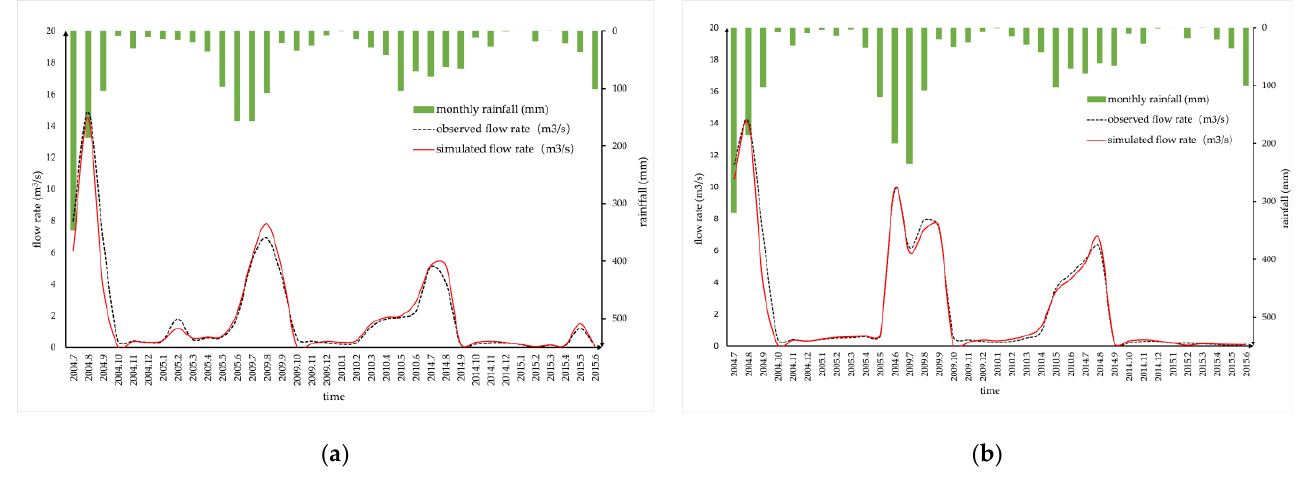
Figure 6. Comparison of WEP-simulated and observed values for Huangtaiqiao Station and Beifeng Station. ( a ) Huangtaiqiao Station; ( b ) Beifeng Station.